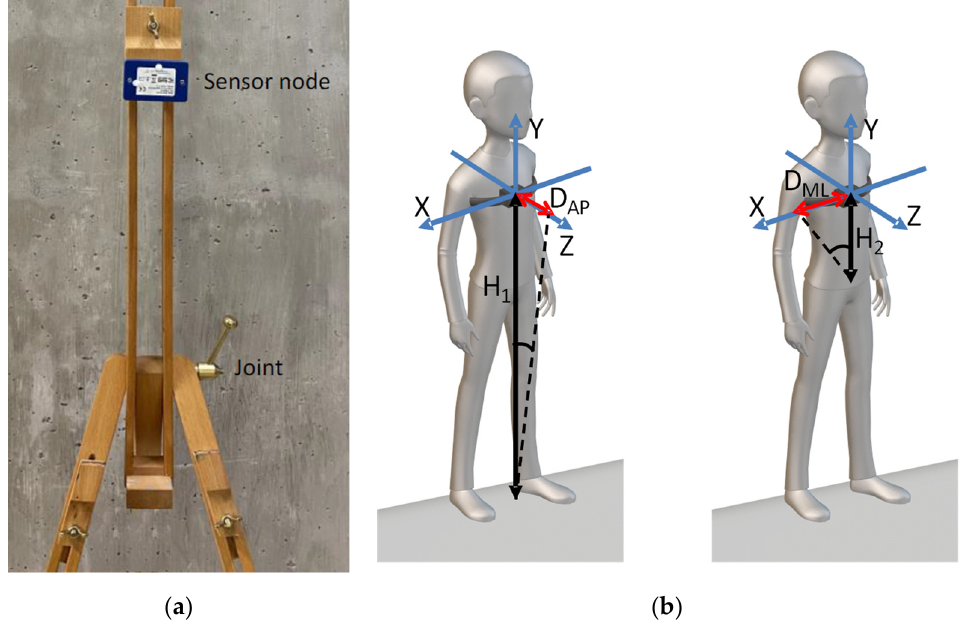
Figure 1. ( a ) The architecture miming standing postural sway behaviors; ( b ) the equivalent node position and representation of main quantities useful for reconstructing the AP and ML dynamics. The structure was moved manually to mimic different postural behaviors. Tilting movements around the belt joint allowed for emulating Medio-Lateral displacement,